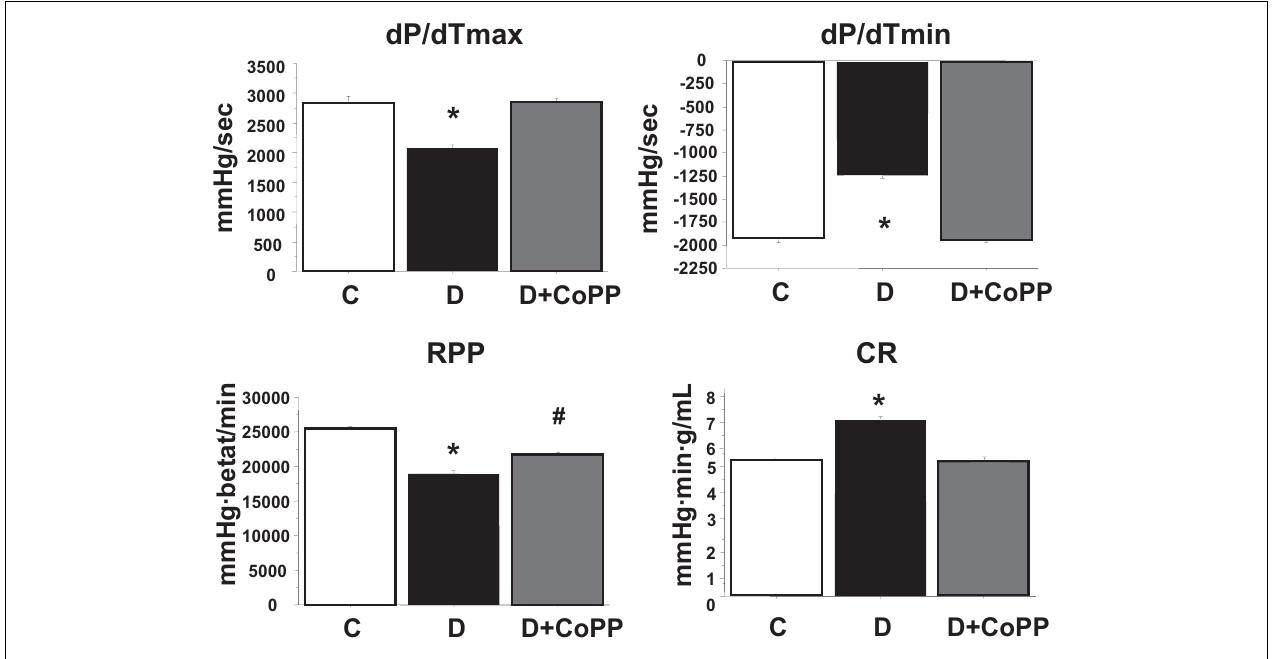
for 3weeks with CoPP (D + CoPP, both n = 16). Data are expressed as means ± SEM. * p < 0.05 vs. other groups; # p < 0.05 vs. CoPP-treated animals.